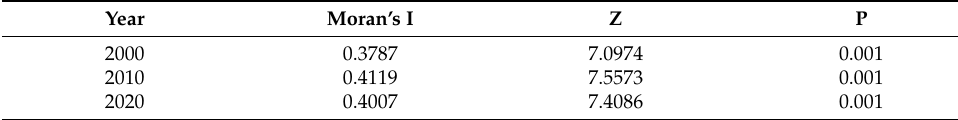
Table A1. Global Moran’s I statistics of ecosystem health.